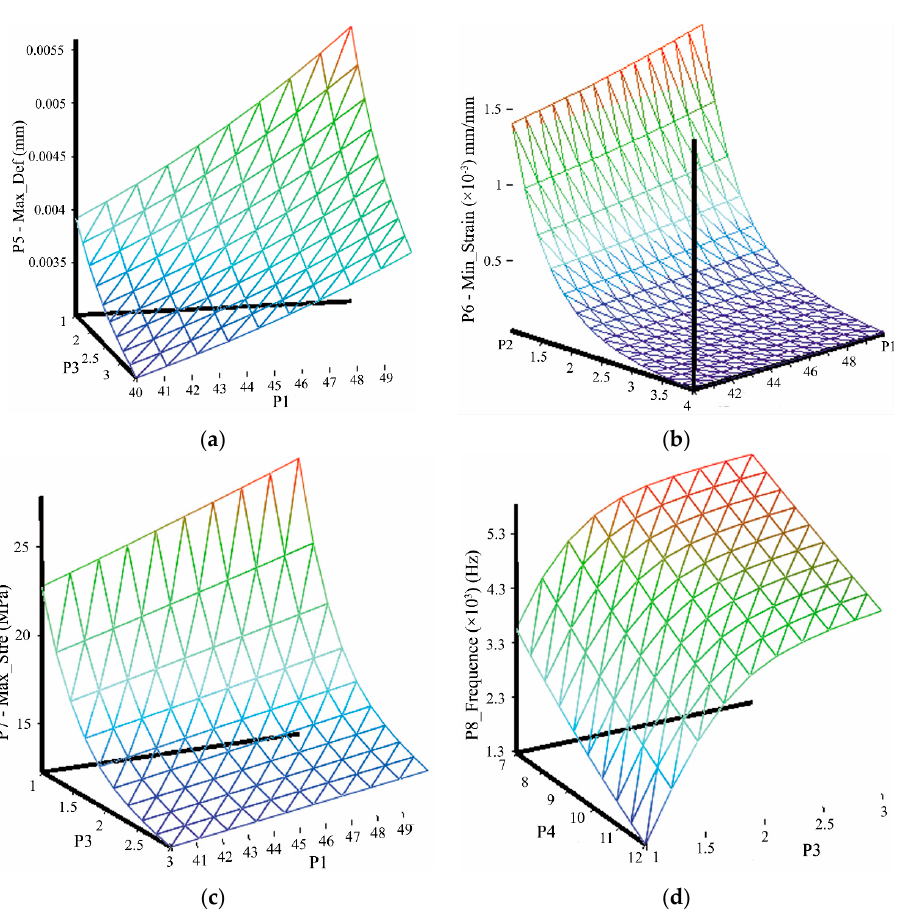
Figure 7. Relationships between design parameters and output variables: ( a ) Maximum deformation versus P1 and P3; ( b ) Minimum strain versus P1 and P2; ( c ) Maximum equivalent stress versus P1 and P3; ( d ) The first response frequency versus P4 and P5.